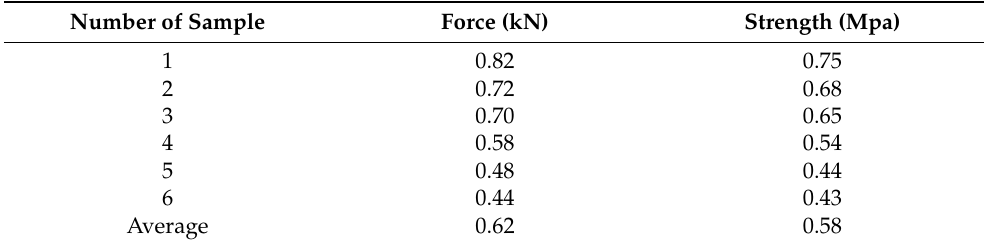
Table 4. Splitting tensile test for 7 days of curing.